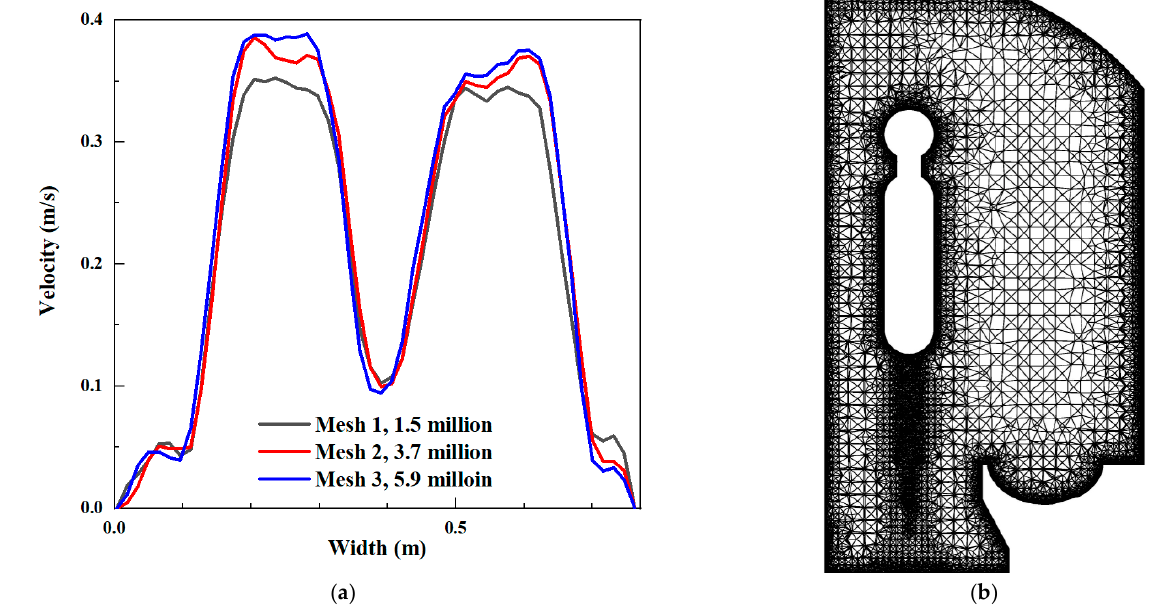
Figure 3. ( a ) Grid independence test; ( b ) illustration of the final mesh for Case 2.